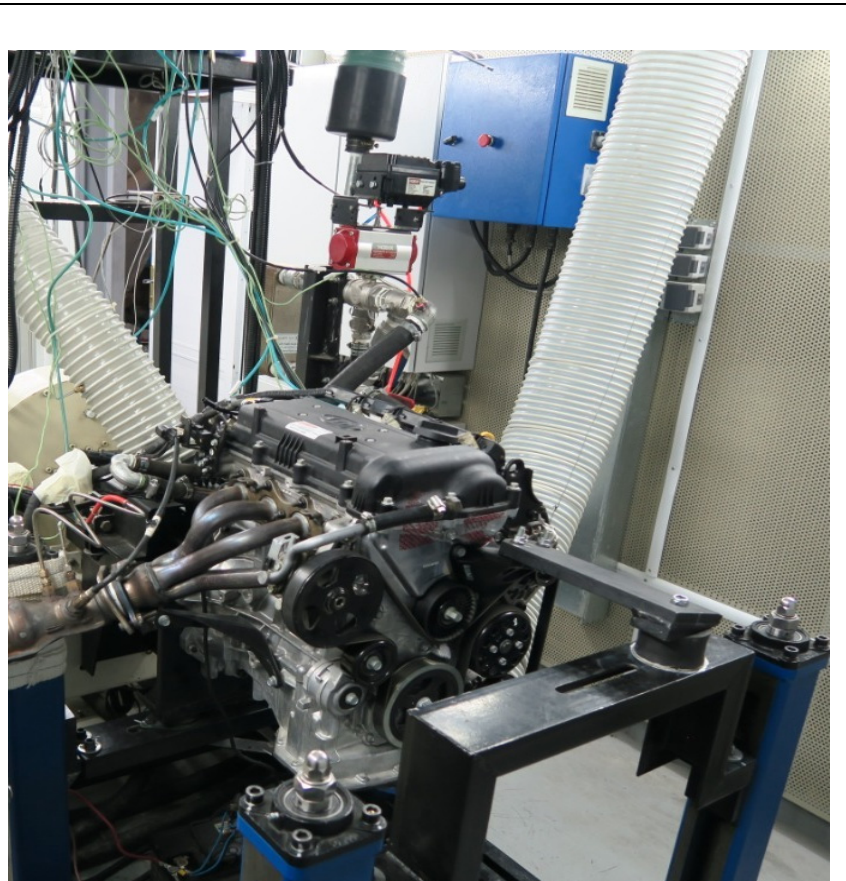
Figure 2. The KIA Cerato engine installed in engine test room . Table 3. Comparison of engine torque, BSFC and nitrogen oxide production rate of AVL model with experimental tests at different engine speeds